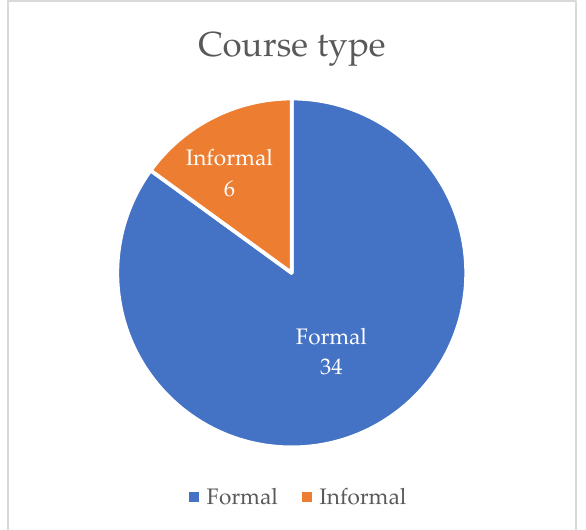
Figure 10. The frequency of studies by course type.